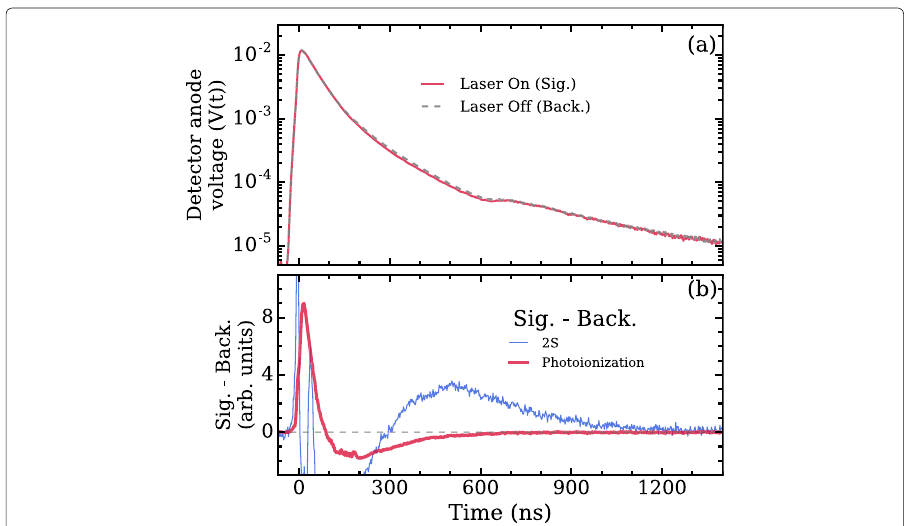
Fig. 3 a Example of lifetime spectra taken with LYSO detector for 3.5 keV positrons impinging on SiO 2 (Sig. and Back.) and, b Background subtracted spectra showing examples of photoionization, and 2 3 S 1 production, as described in the text. The signal and background spectra in ( a ) correspond to the photoionization signal in ( b